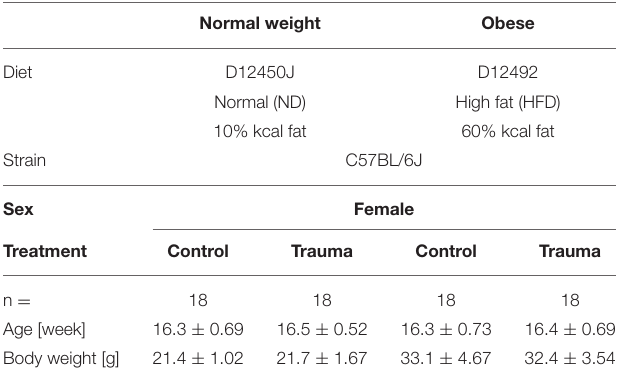
TABLE 1 | Characteristics for animals used for induction of a blunt muscle trauma.